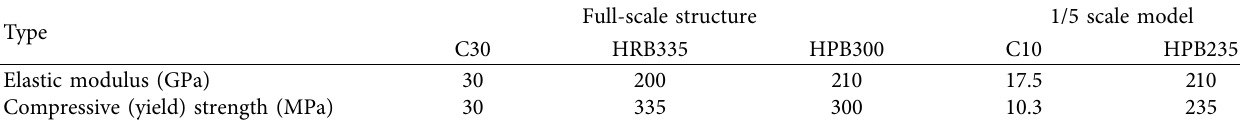
Table 5: Material